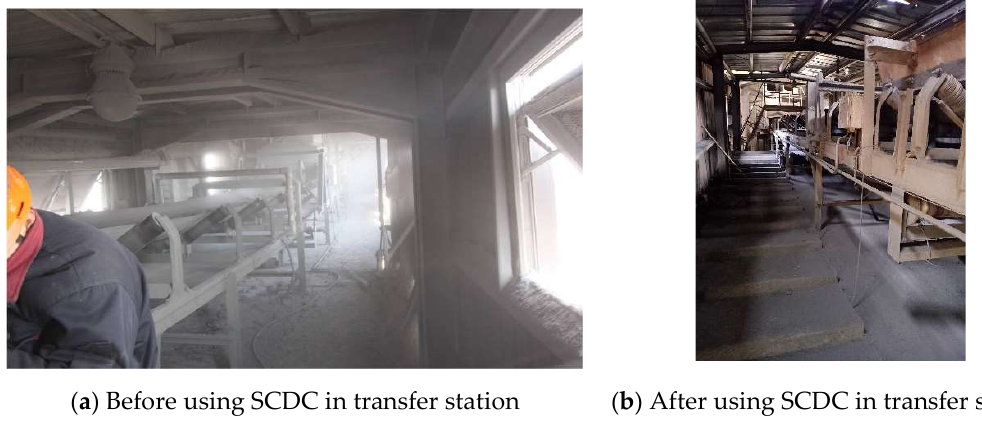
Figure 14. Comparison of dust distribution before/after SCDC used in transfer station.